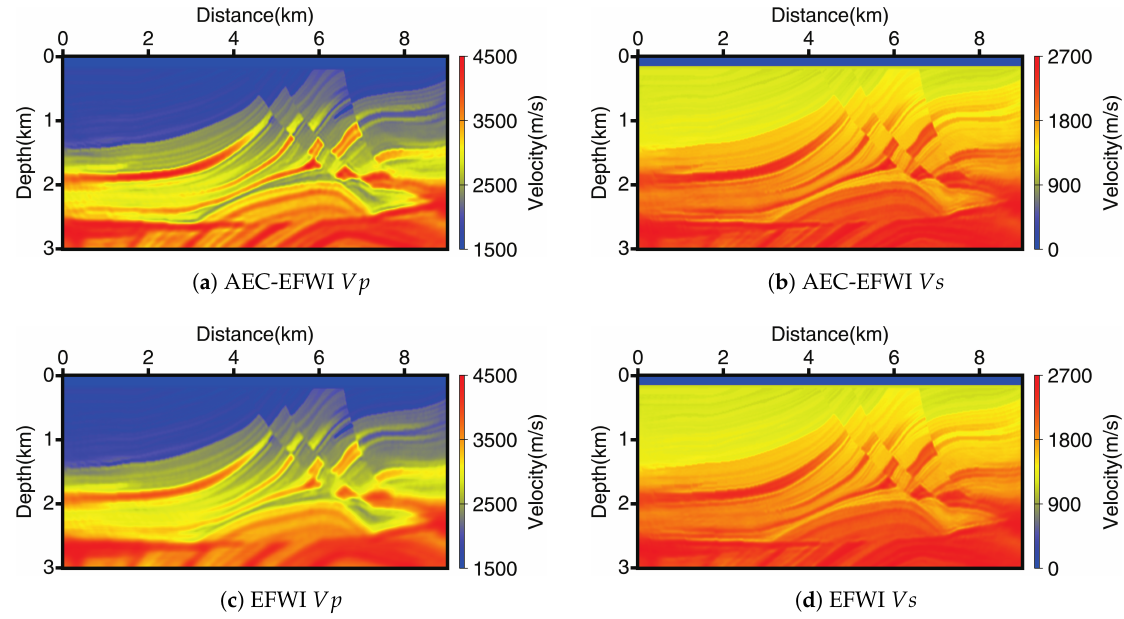
Figure 13. Multiparameter inversion results: ( a ) Vp and ( b ) Vs using modified acoustic-elastic coupled-elastic full-waveform inversion (AEC-EFWI), and ( c ) Vp and ( d ) Vs using elastic full-waveform inversion (EFWI).